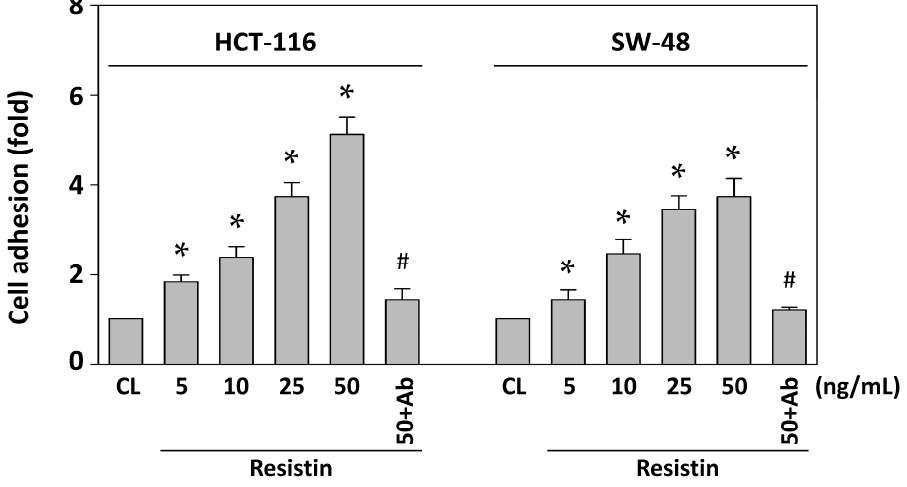
Figure 1. Resistin induces HCT-116 and SW-48 cell adhesion to HUVECs. HCT-116 and SW-48 cells were maintained as controls or stimulated with resistin and then stained with a crystal violet solution. The adhesion of HCT-116 and SW-48 cells to HUVECs was assessed. HCT-116 and SW-48 cells incubated with resistin (50 ng/mL) plus resistin-neutralizing antibodies (Ab) exhibited no increase in HUVEC adhesion. Data represent the mean ± standard error of the mean (SEM) from four independent experiments. * p < 0.05 vs. control cells; # p < 0.05 vs. cells treated with resistin only.